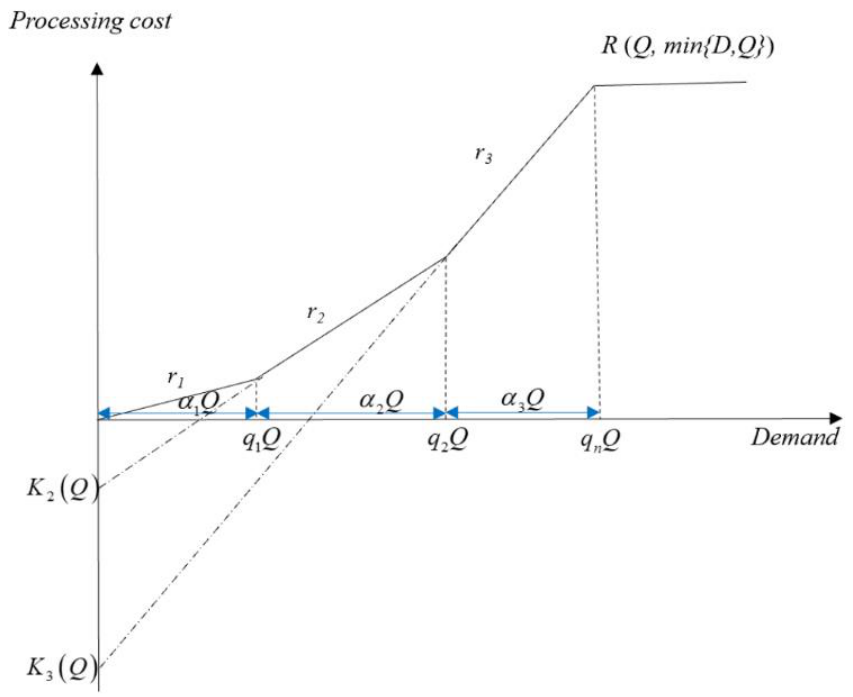
Figure 1. The production cost when the cores are divided into three categories.